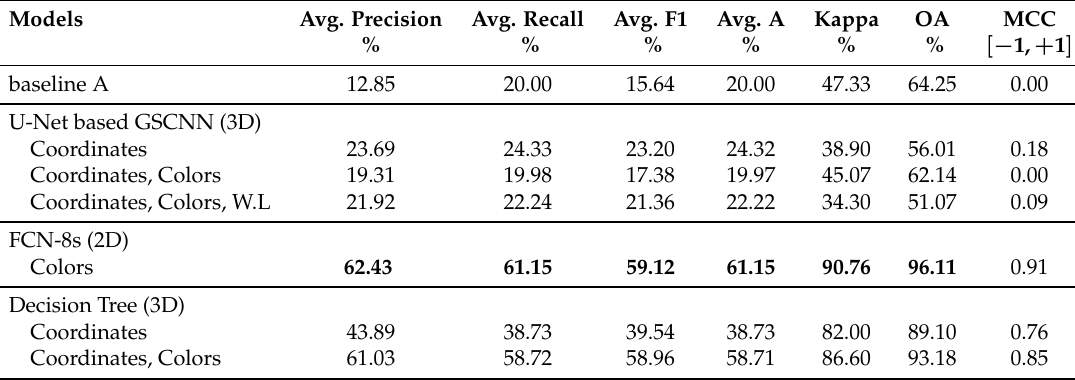
Table 3. Overall quantitative comparison of the GSCNN, FCN-8s, and the decision tree. We report (from left to right) average precision, average recall, average F1 score, average accuracy, kappa score, overall accuracy, and MCC. Values in bold format are the highest numbers for the corresponding metrics, with the exception for baseline A. See Table 4 for per class results, and Appendix B for the confusion matrices. Note that we abbreviate weighted loss with (W.L).